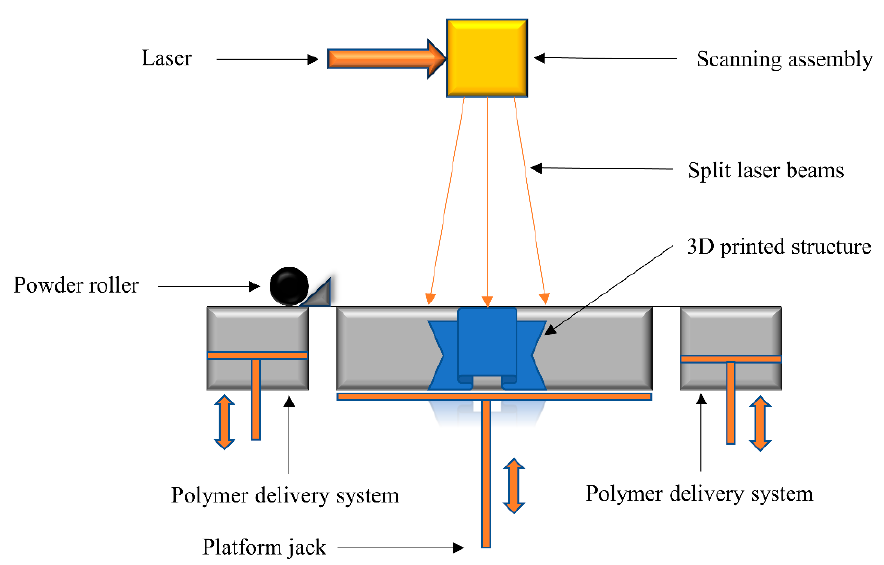
Figure 4. Schematic diagram of the selective laser sintering laser (SLS) process. Redrawn from [95].